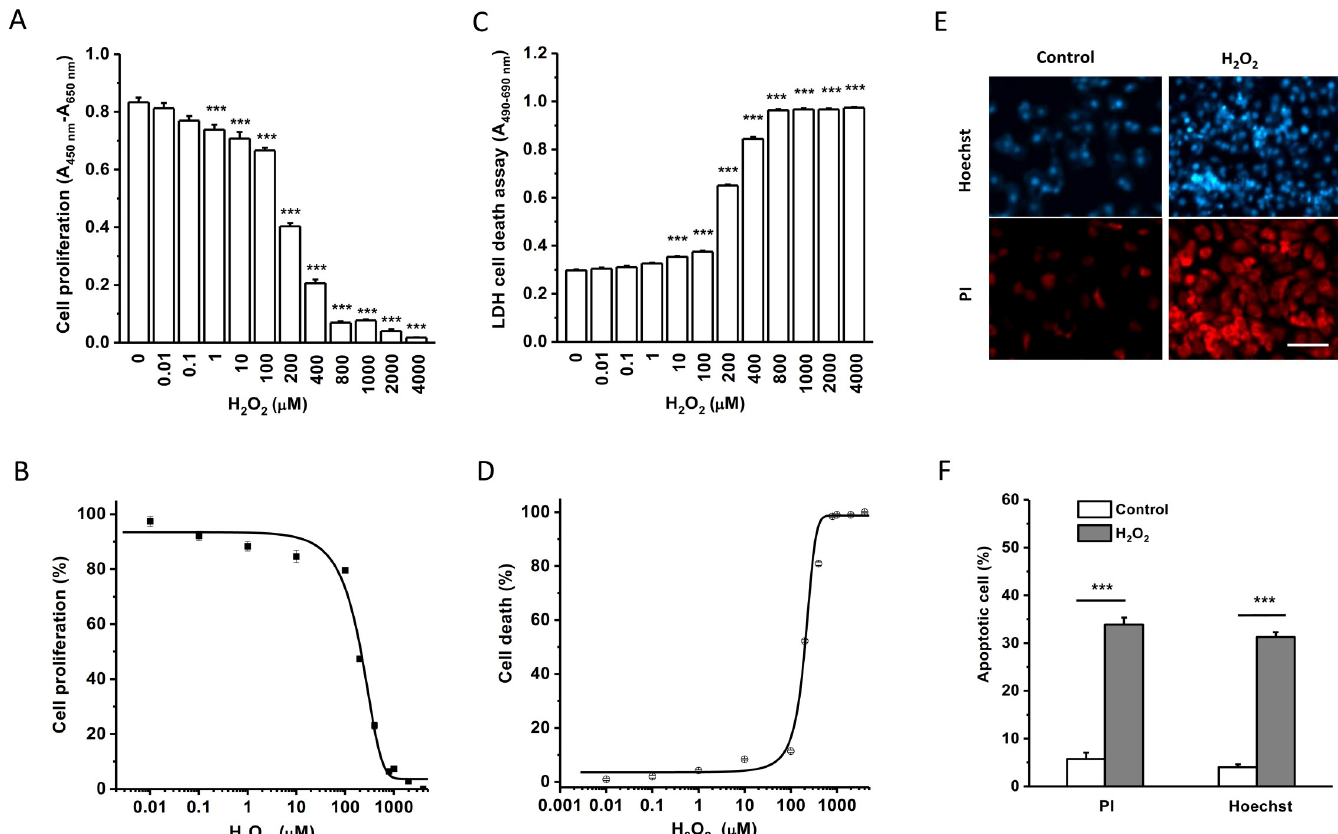
Fig 2. Cell proliferation and death under H 2 O 2 -induced oxidative stress conditions. The proliferation of HK-2 cells was assayed with WST-1 reagents after a 24-hour incubation with different concentrations of H 2 O 2 . The absorbance was measured at a wavelength of 450 nm with a reference wavelength of 650 nm. A, Mean ± SEM data ( n = 8 for each group). B, The normalised dose-response data was fitted with the equation: y = A2 + (A1-A2)/(1 + (x/x0)^p), and the IC 50 was 114.9 μ M. C, The cytotoxicity of HK-2 cells was assayed using LDH reagents after a 24-hour incubation with H 2 O 2 , and the absorbance was measured at a wavelength of 490 nm and a reference wavelength of 680 nm. D, The dose–response curve showed an IC 50 of 199.4 μ M for cytotoxicity ( n = 8 for each group, ANOVA with Bonferroni post hoc test was used for group comparison). E, Examples of Hoechst 33342 (Hoechst) and propidium iodide (PI) nuclear staining. Scale bar = 100 μ m. F, Mean ± SEM data for apoptotic cell counting ( n = 6 for each group). ��� P <